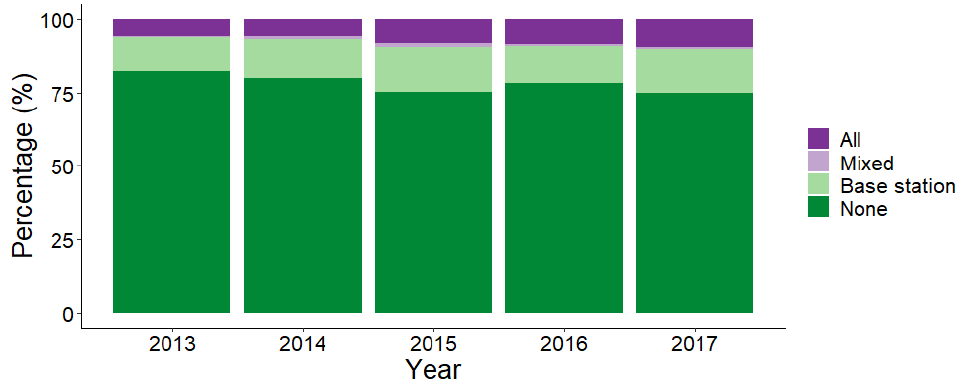
Figure 14. Deployment distribution between year and usage of rich nodes.